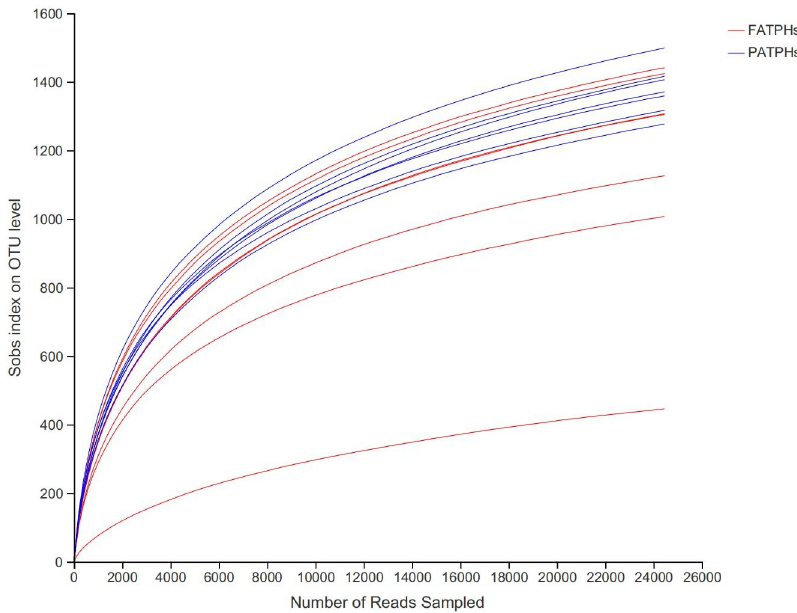
Fig 1. Rarefaction curves of normalized OTUs of 14 fecal samples obtained from the FATPHs and PATPHs.